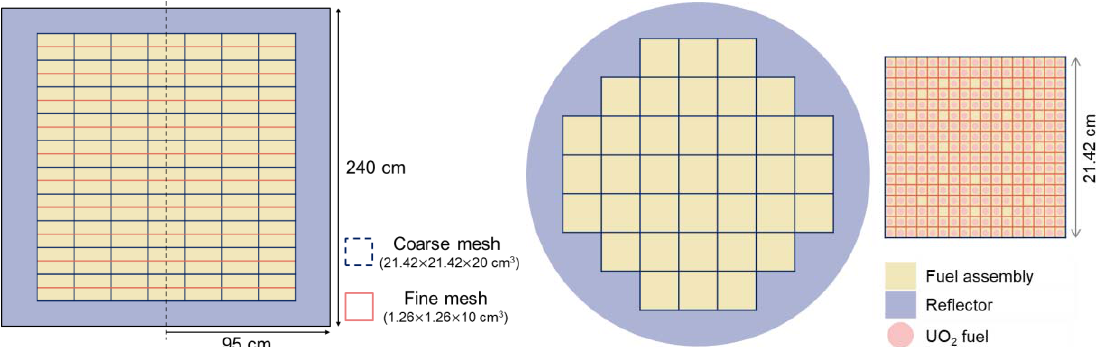
Figure 4. Reactor core configuration